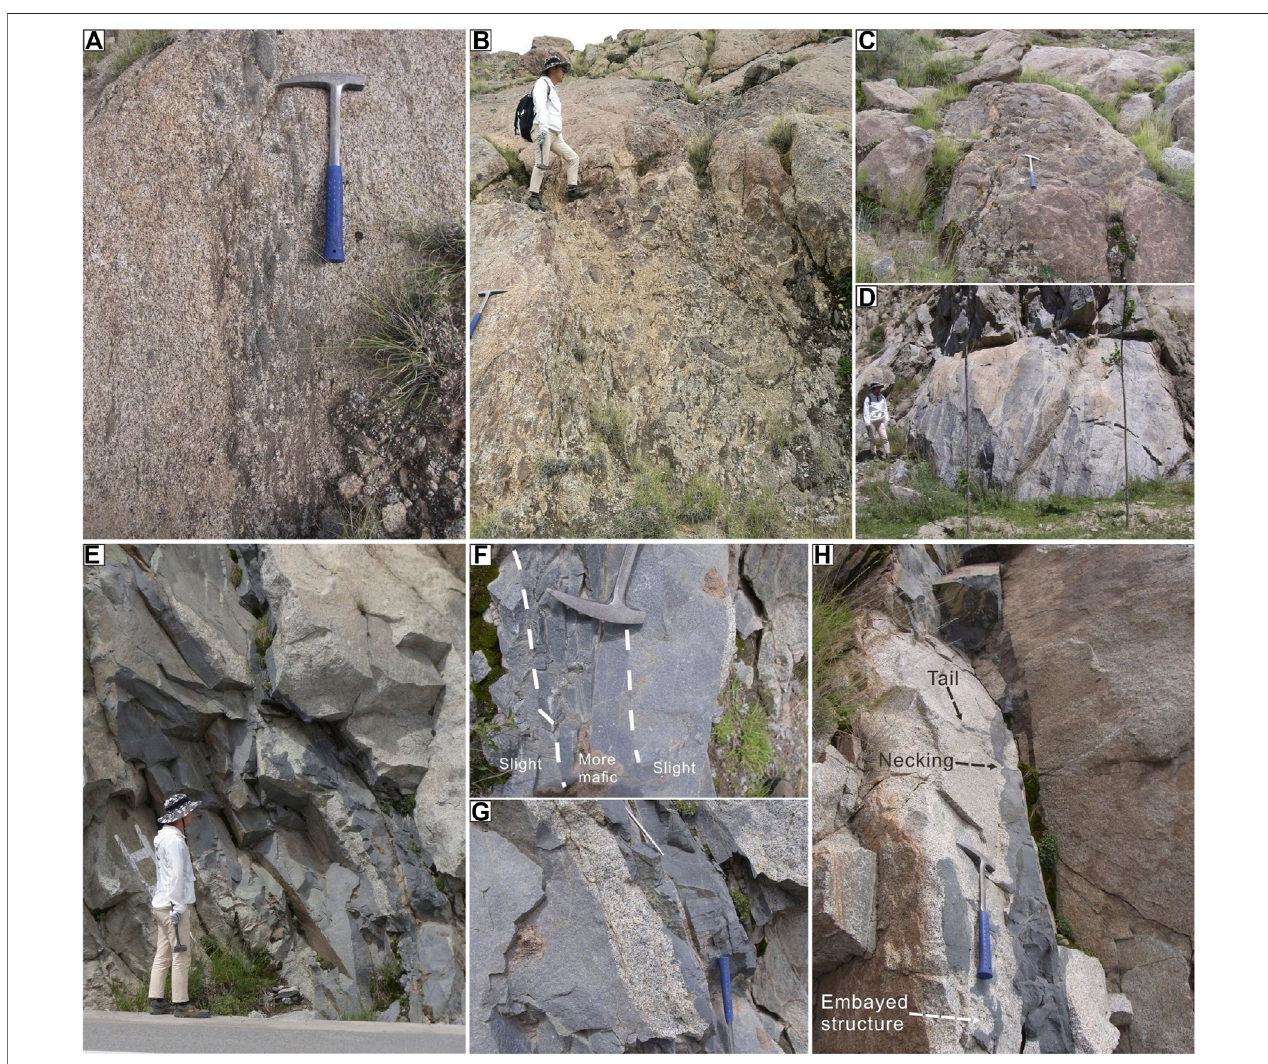
FIGURE 3 | Field photos showing the various types of enclave swarms and dikes. (A) A dike-like monogenic swarm consists of similar MMEs enclosed in granodiorite. These MMEs have similar shapes and compositions and are oriented in the same direction. (B) A polygenic swarm consists of many types of MMEs with different sizes and shapes. Only a weak preferred orientation could be seen. (C) A monogenic swarm consists of similar enclaves, but no obvious orientation. (D) A monogenic swarm consists of similar enclaves with obvious orientation along the fl ow direction of host magma. (E) Synplutonic dike, occasionally, with lobate contacts and fl ow tails. (F) Close-up of (E) showing the compositional gradation from the core to the margin of the synplutonic dike. (G) Close-up of (E) showing the embayed host within the synplutonic dike. (H) Synplutonic dike showing the lobate contacts. The width of the dike varies along its strike due to necking and embaying